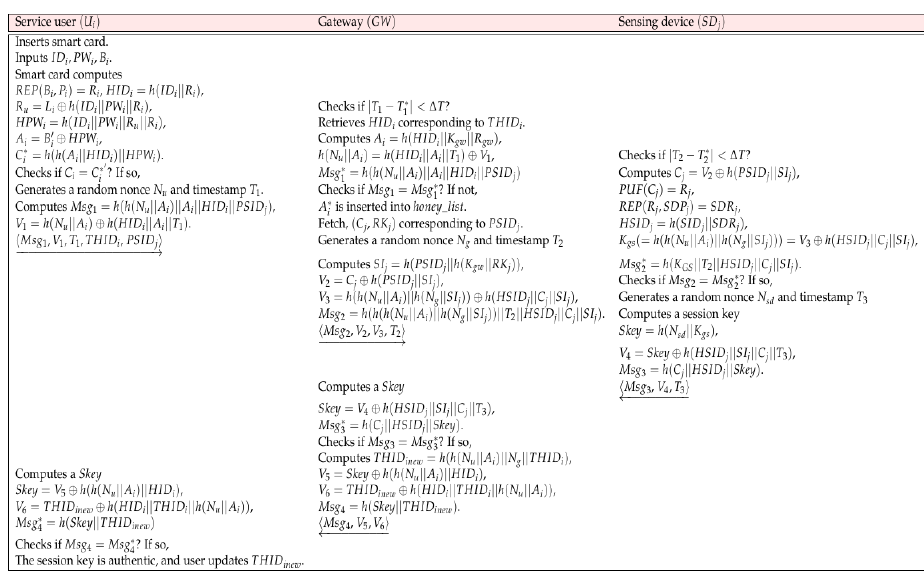
Figure 3. Login and authentication